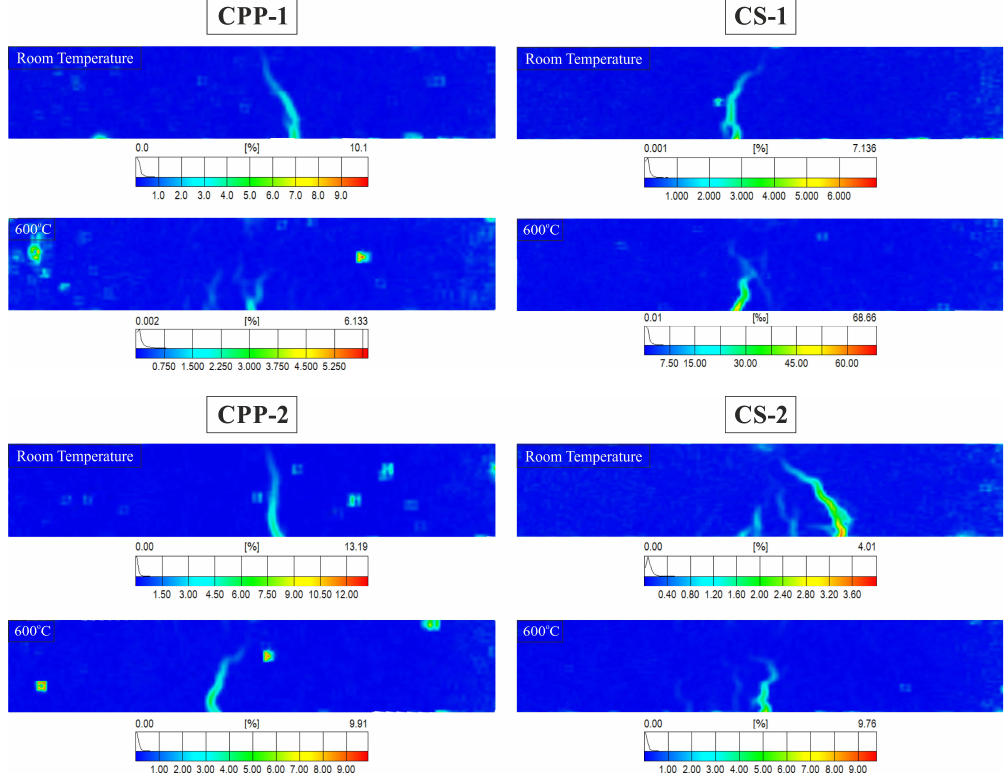
Figure 11. Von Mises strains in PPF- and SF-reinforced UHPC specimens at peak load with 1% and 2% fibre content at room temperature and after exposure to 600 °C.